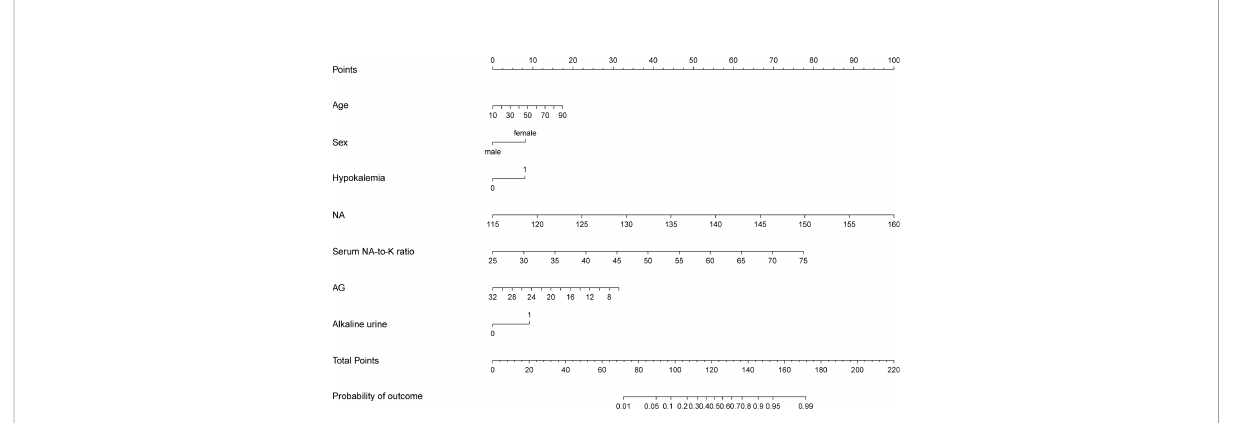
FIGURE 1 The prediction model presented by nomogram graph. Estimated the probability of primary aldosteronism using the nomogram, located the clinical predictors on each variable axis, and drew the vertical line from that value to the top points scale for calculating the score for each predictor. The total scores from each variable value represent the possibility of primary